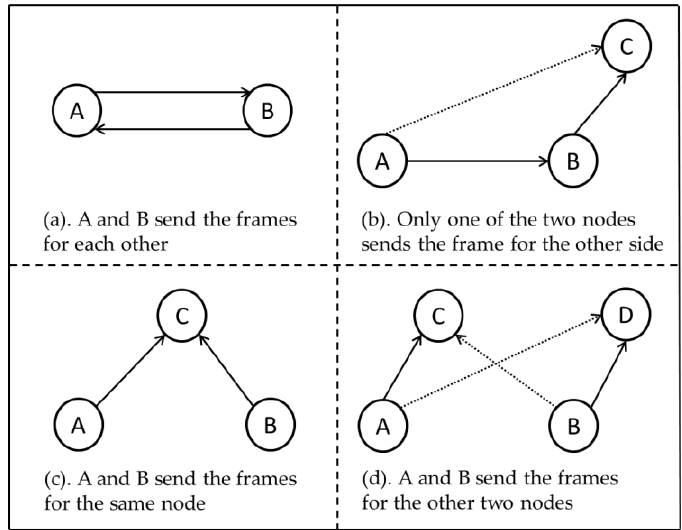
Figure 1. Four communication modes corresponding to the two nodes sending signals simultaneously.